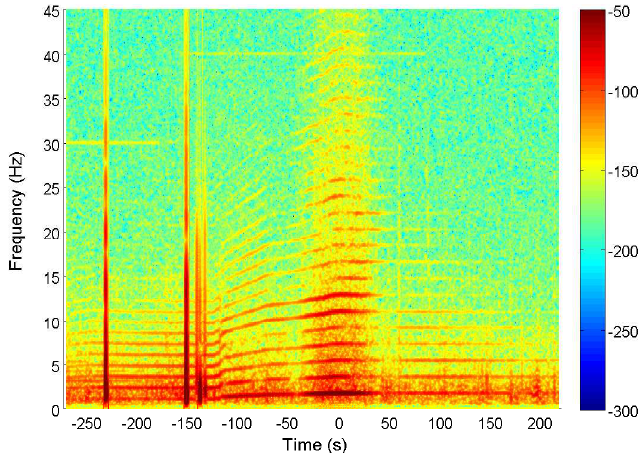
Figure 5. The time-frequency characteristic of the magnetic